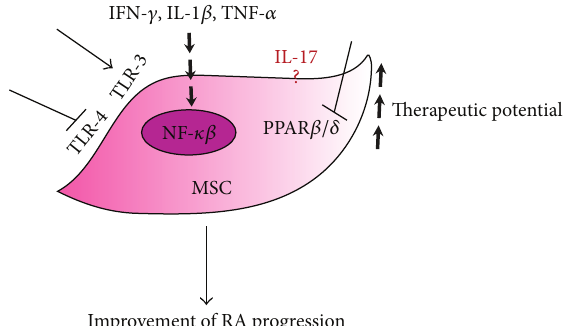
Figure 1: Preconditioning of MSCs to improve their therapeutic potential for arthritis treatment. Proinflammatory cytokines such as IFN- 𝛾 , IL-1 𝛽 , and TNF- 𝛼 and activation of the TLR-3 pathways are able to increase the immunosuppressive potential of MSCs probably through the activation of NF- 𝜅𝛽 activity. PPAR 𝛽 / 𝛿 inhibition, either chemical or genetic, also increased the therapeutic potential of MSCs.TLR-4inhibitioncouldalsoenhancetheimmunosuppressive potential of MSCs. The specific role of IL-17 in the suppressive effect of MSCs still remains a subject of